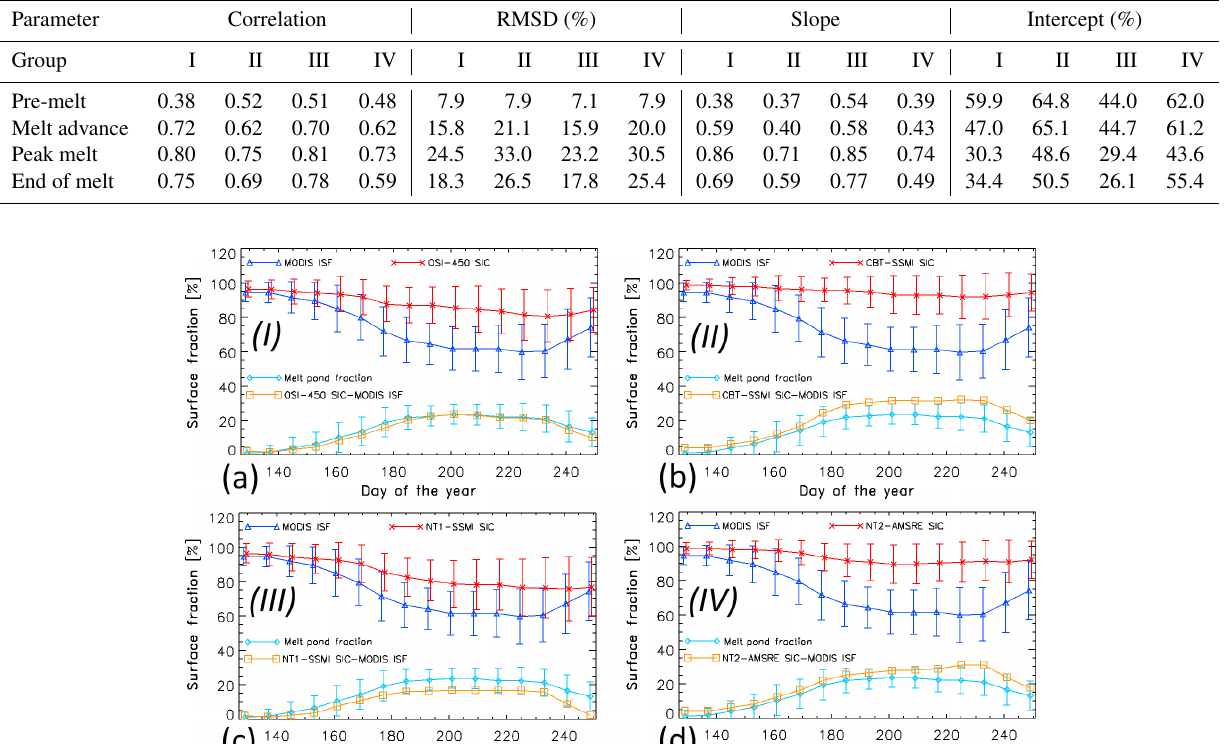
Table 4. Mean values of linear correlation, root-mean-squared difference (RMSD), and slope as well as intercept of the linear regression between passive microwave sea-ice concentration and MODIS ice surface fraction for product groups I to IV (see text and caption of Table 3 for further information).